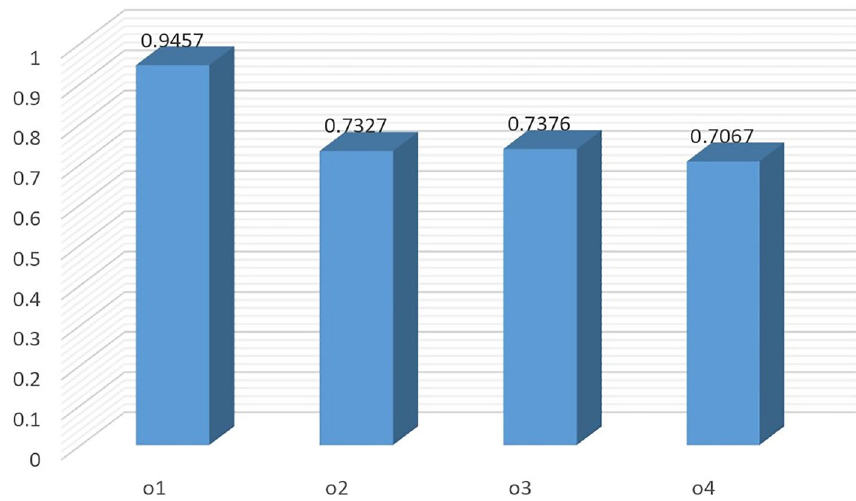
Figure 2. Graphical representation of the proposed method ranking.